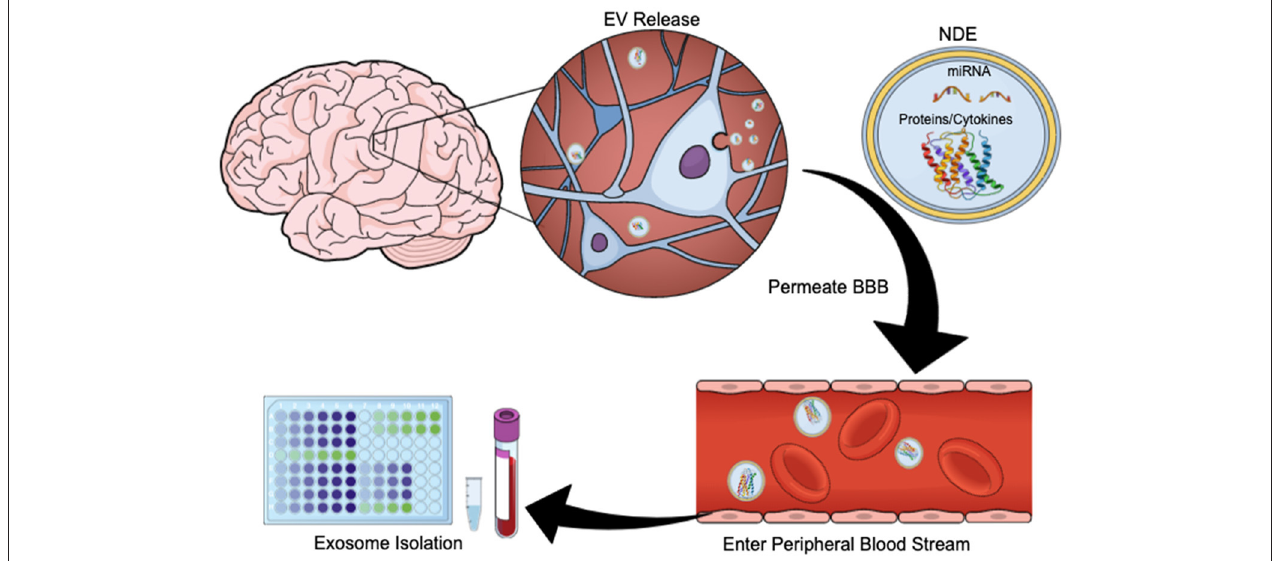
FIGURE 1 | Exosome Release Schematic. EVs are released by neurons and glia. Their cargo often contains protein, cytokines, and/or miRNA. These exosomes can cross the blood brain barrier and enter the peripheral bloodstream, allowing for quantification and study. This figure was created using the Mind the Graph online platform